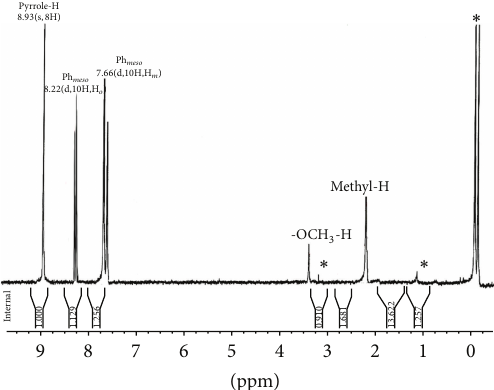
Figure 2: 1 H NMR spectra of p -OCH 3 phO-Zn-t-( p -CH 3 )PP in CDCl 3 at 298 K. Starred peaks are solvents